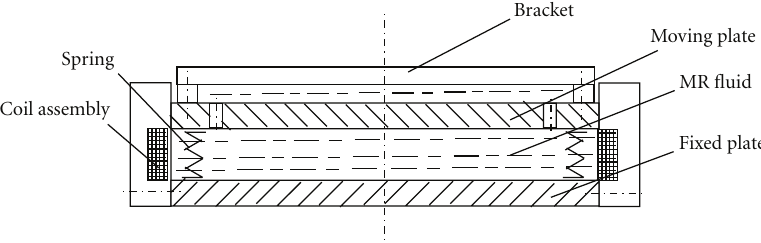
Figure 1: Operational principle of a circular plate MR isolating damper.